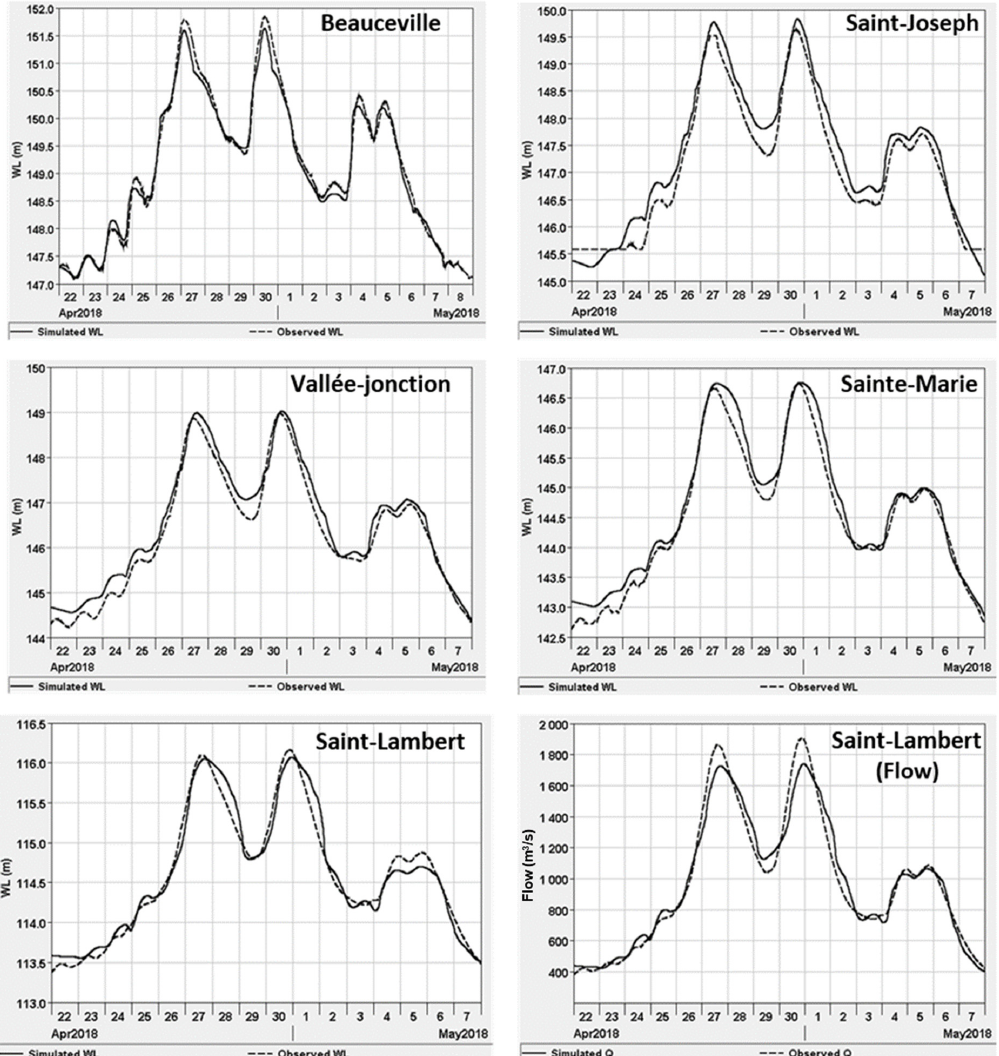
Figure 10. Simulated vs. observed values for validation event V2.